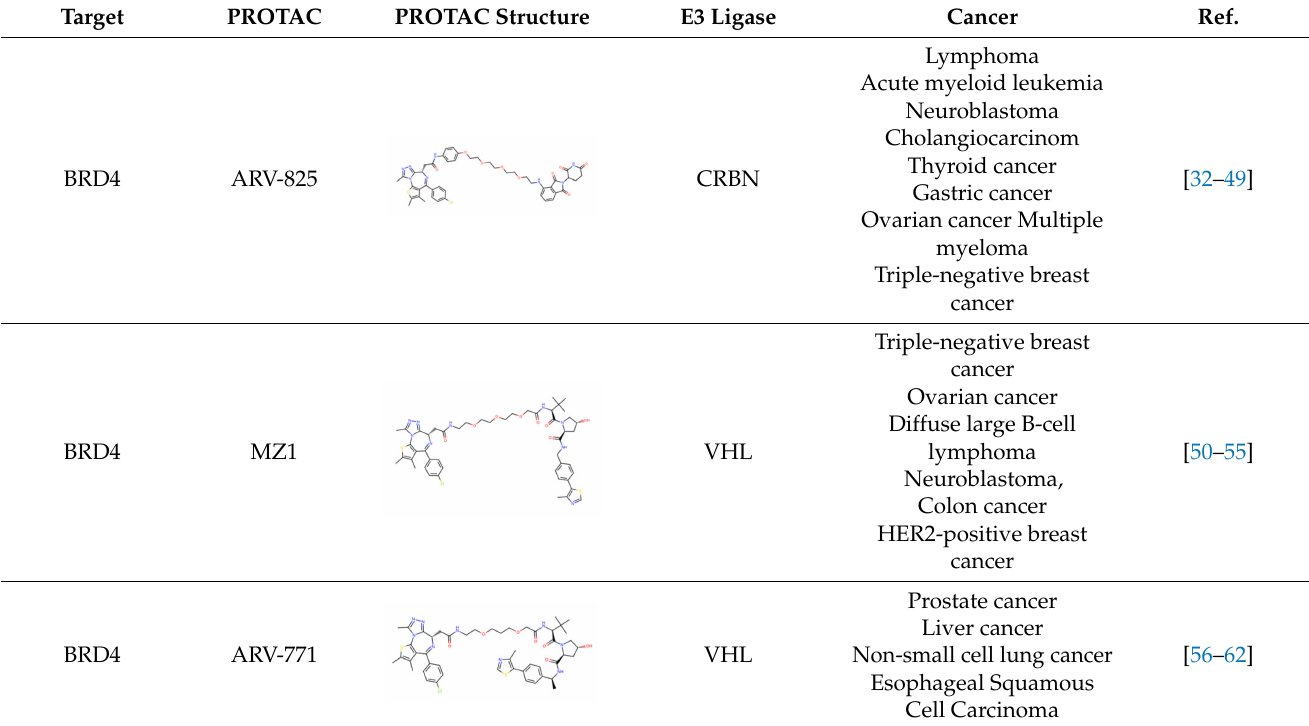
Table 1. PROTACs for Histone acetylation targets